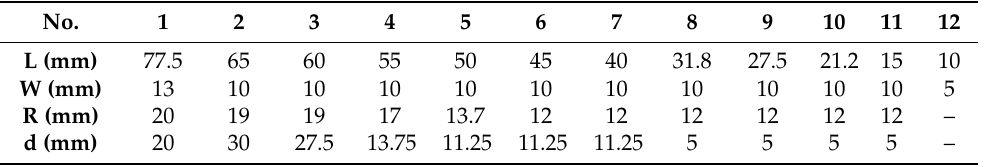
Table 1. Illustration of optimum values of the parameters.